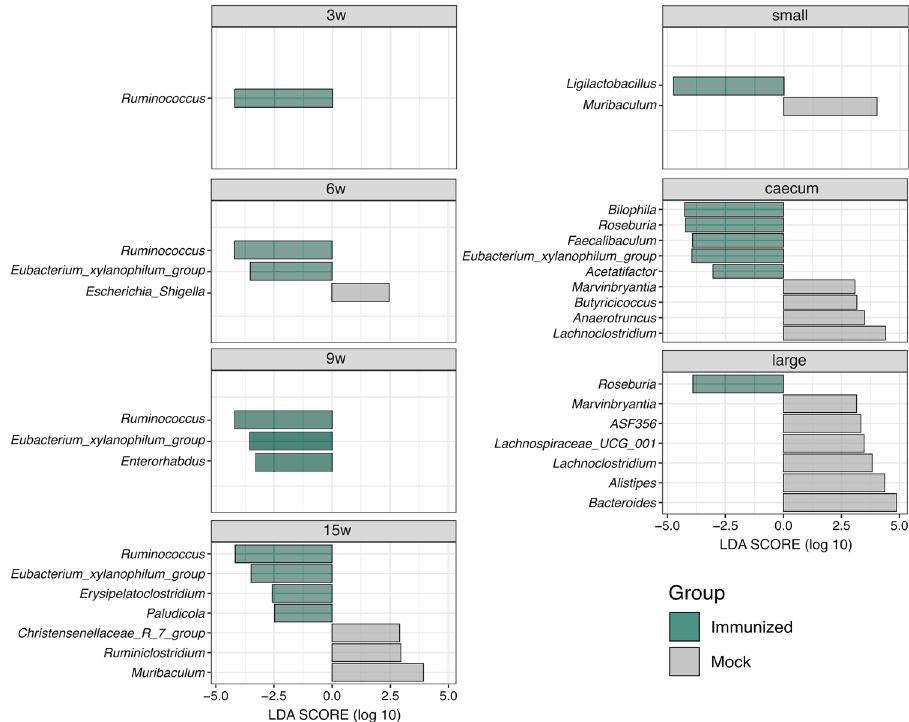
Fig. 3 Discriminative genera between HTI- and PBS-immunized mice following vaccination. LEfSe analysis comparing the relative abundance of bacterial genera between Immunized and Mock groups during vaccine administration (pooled fecal samples at 3 week, 9 week, 6 week and 15 week) and at end of study at week 15 for individual fecal samples from small intestine, caecum and large intestine. Horizontal bars represent the effect size for each discriminant genus ( p < 0.05 and LDA scores > 2.0). The bar length represents the log10 transformed LDA score, indicated by vertical